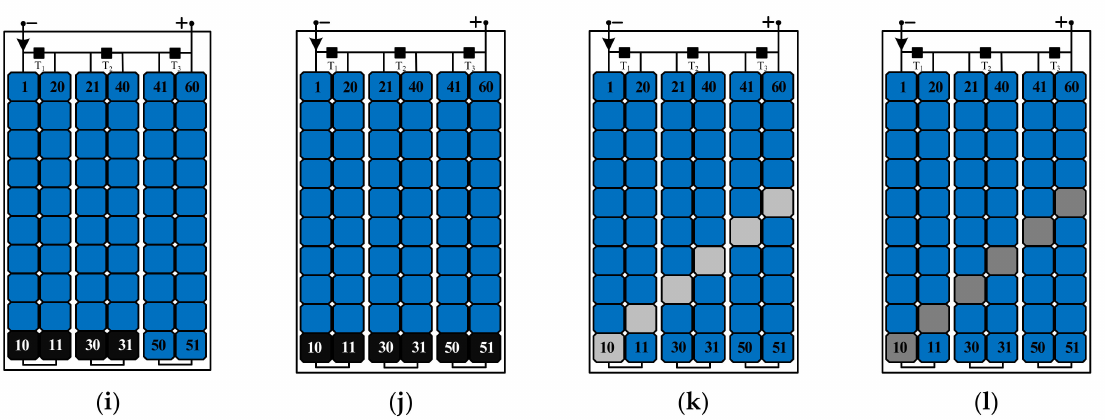
Figure 11. Mismatch scenarios: ( a ) Scenario 1, ( b ) Scenario 2, ( c ) Scenario 3, ( d ) Scenario 4, ( e ) Scenario 5, ( f ) Scenario 6, ( g ) Scenario 7, ( h ) Scenario 8, ( i ) Scenario 9, ( j ) Scenario 10, ( k ) Scenario 11, and ( l ) Scenario